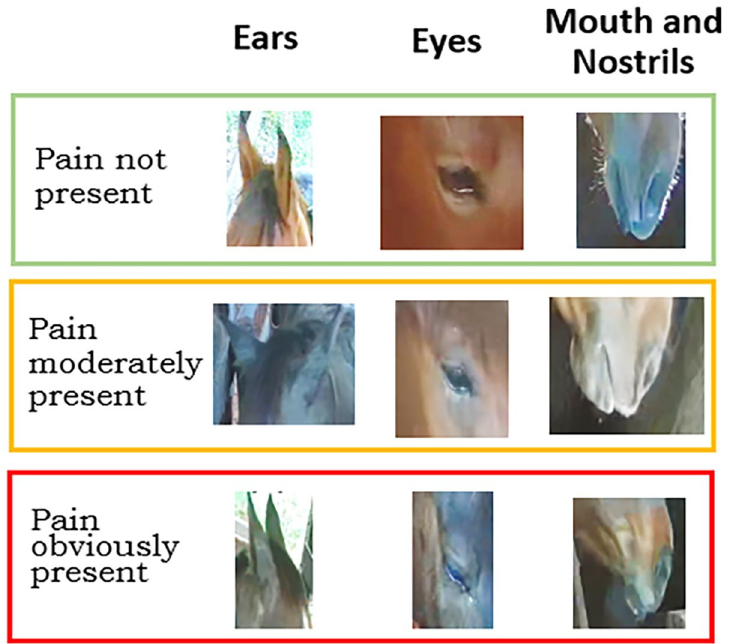
Fig 2. Horse face regions and pain levels for evaluation by computer modeling. Ears: Considers ear position, distance between them and direction. Eyes: Considers size of the orbital area, muscular tension above the eye, visibility of underlying bone surfaces. Mouth and nostrils: Considers level of mouth and nostrils straining, tension, size of mouth-collum (line between the upper and lower lips) and nostril dilation.